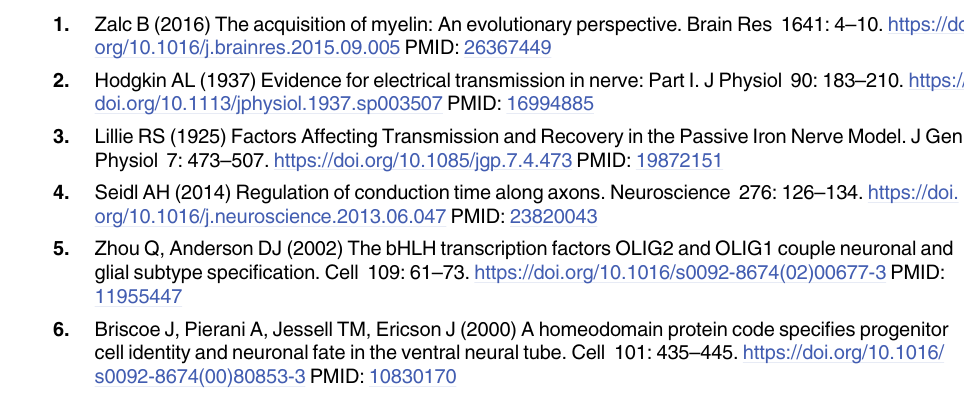
S2 Video. Ypel3 is required for OPC and perineurial glia development. mz ypel3 mutant. Time-lapse video from 50 to 62 hpf. Each frame is a projection of a 50 μ m deep Z-stack of lat- eral views acquired every 25 minutes using a spinning disk microscope. Dark yellow arrows indicate OPCs. Green arrows indicate perineurial glial cells that have exited the CNS. Scale bar: 20 μ m.